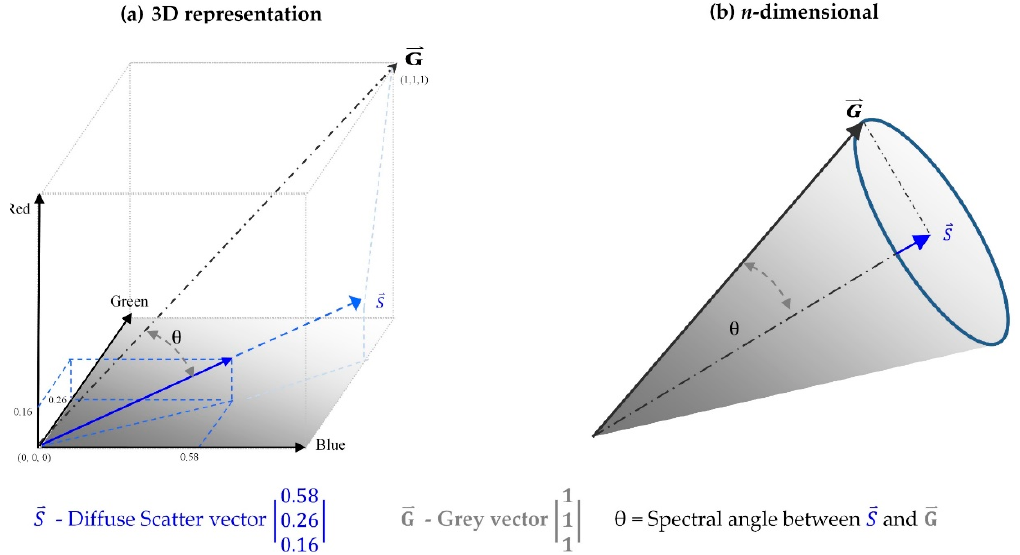
Figure 4. 3D example showing the spectral angle rotation θ from grey vector to a 3-band Rayleigh scatter vector. ( a ) Is a 3D visualisation of the relationship between grey vector and diffuse scatter vector and ( b ) an equivalent for n -dimensions without the n axis shown.